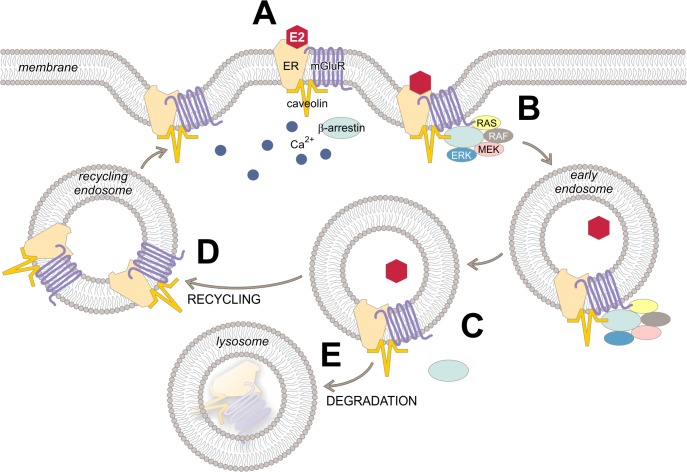
Proposed mechanism for the role of Arrb1 in internalization and signaling of mERα/ ERαΔ4 (depicted as mERα in figure for simplicity).(A) Membrane ERα is part of a G-protein coupled receptor complex which includes mGluR1a and caveolin (reviewed in [5]). (B) Following E2 activation of mERα, Arrb1 is recruited to this receptor complex where it binds organizes Raf/MEK/ERK signaling and the endocytic machinery needed to internalize mERα into endosomes. In the absence of Arrb1, ERα internalization and ERK1/2 (MAPK) signaling are blocked. Eventually, the internalized mERα-mGluR1a loses Arrb1 (C), signaling ceases and the receptor complex is (D) recycled and trafficked to the cell surface, or (E) sorted to lysosomes for degradation.